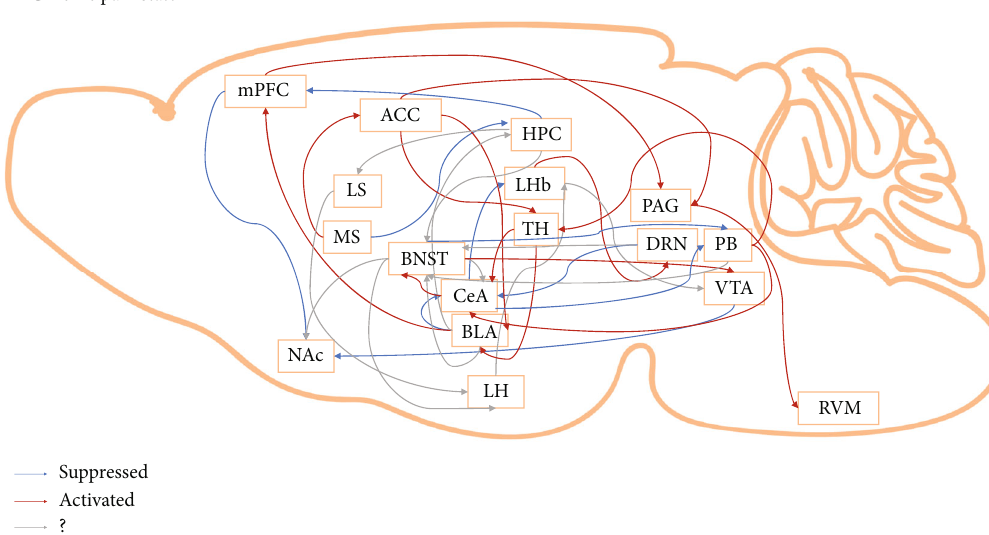
Figure 2: Potential neural circuits underlying the comorbidity of chronic pain and anxiety. ACC: anterior cingulate cortex; BLA: basolateral amygdala; BNST: bed nucleus of the stria terminalis; CeA: central amygdala; DRN: dorsal raphe nucleus; HPC: hippocampus; LH: lateral hypothalamus; LHb: lateral habenula; LS: lateral septum; mPFC: medial prefrontal cortex; MS: medial septum; NAc: nucleus accumbens; PAG: periaqueductal gray; PB: parabrachial nucleus; RVM: rostromedial ventral medulla; TH: thalamus; VTA: ventral tegmental area. ?, not con fi rmed for chronic pain-related